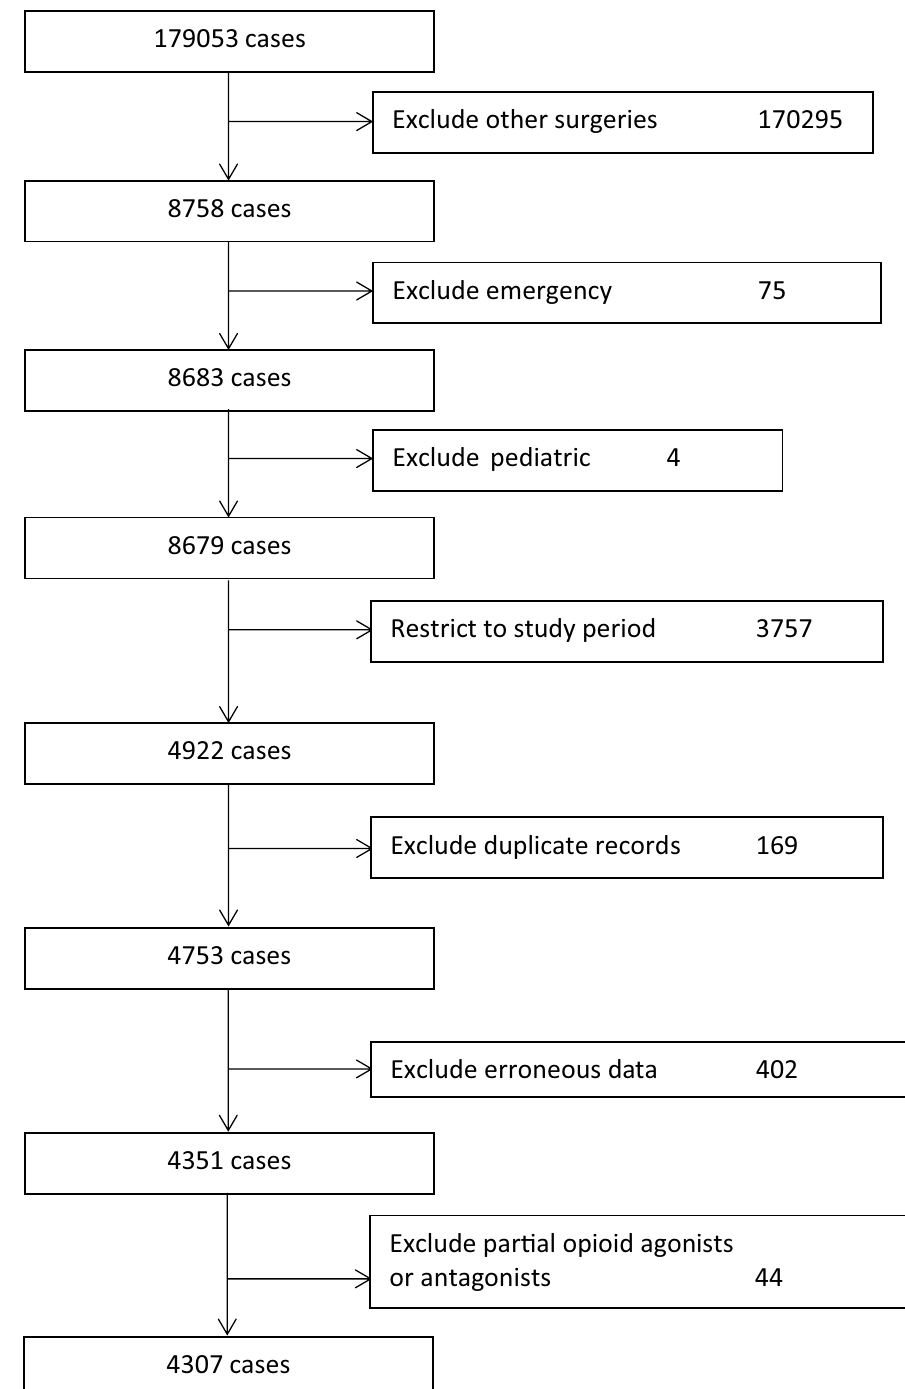
Figure 1. Flow diagram of inclusions and